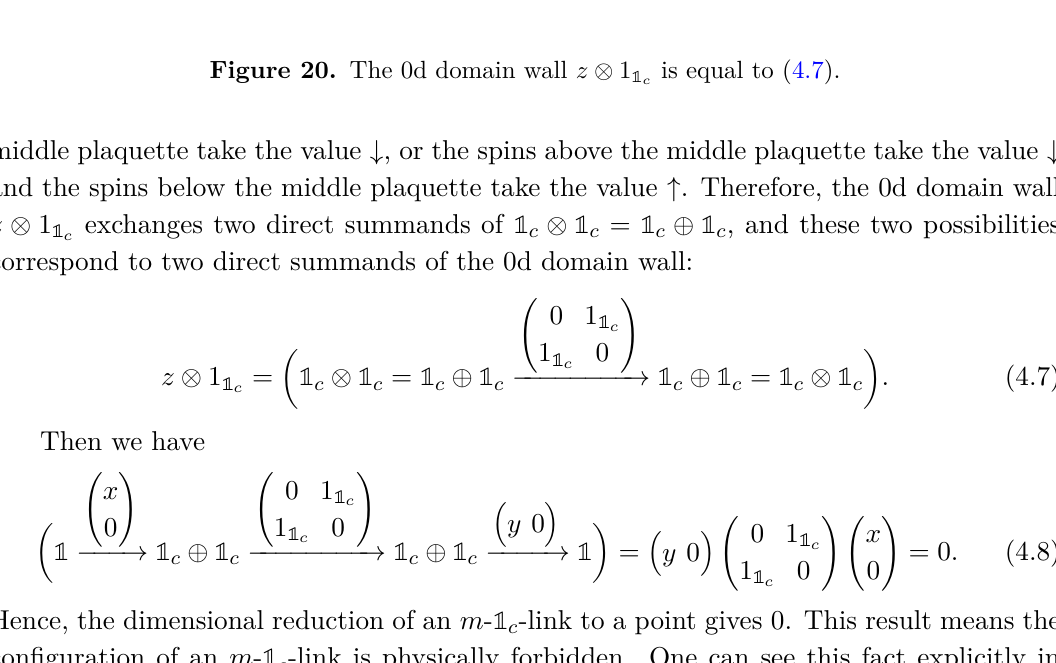
Figure 20. The 0d domain wall z ⊗ 1 1